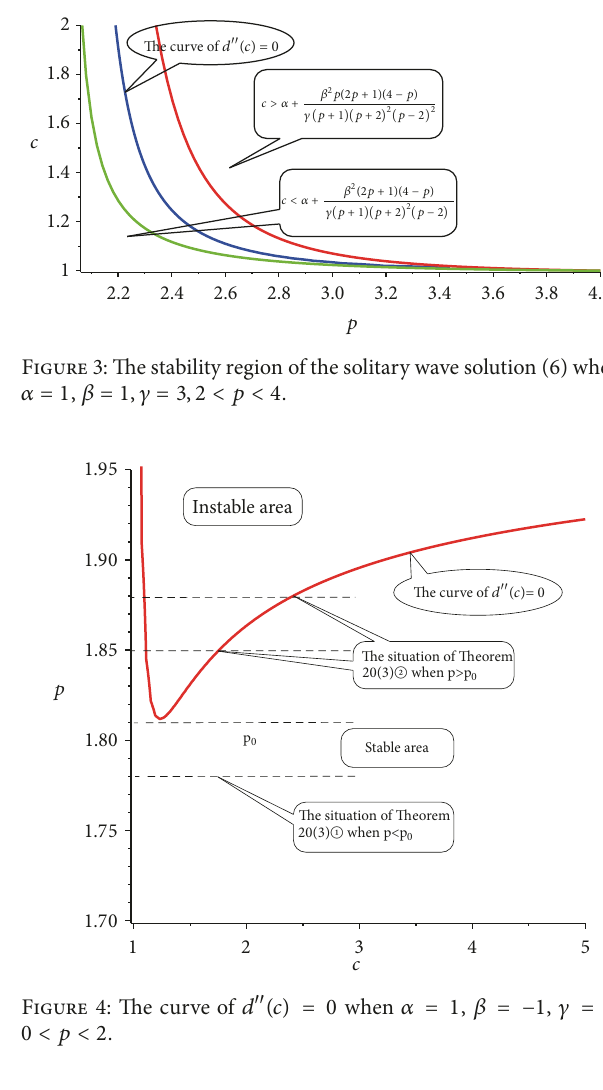
2 < 𝑝 < 4 , so there will be wave velocity interval that makes 𝑑 󸀠󸀠 (𝑐)